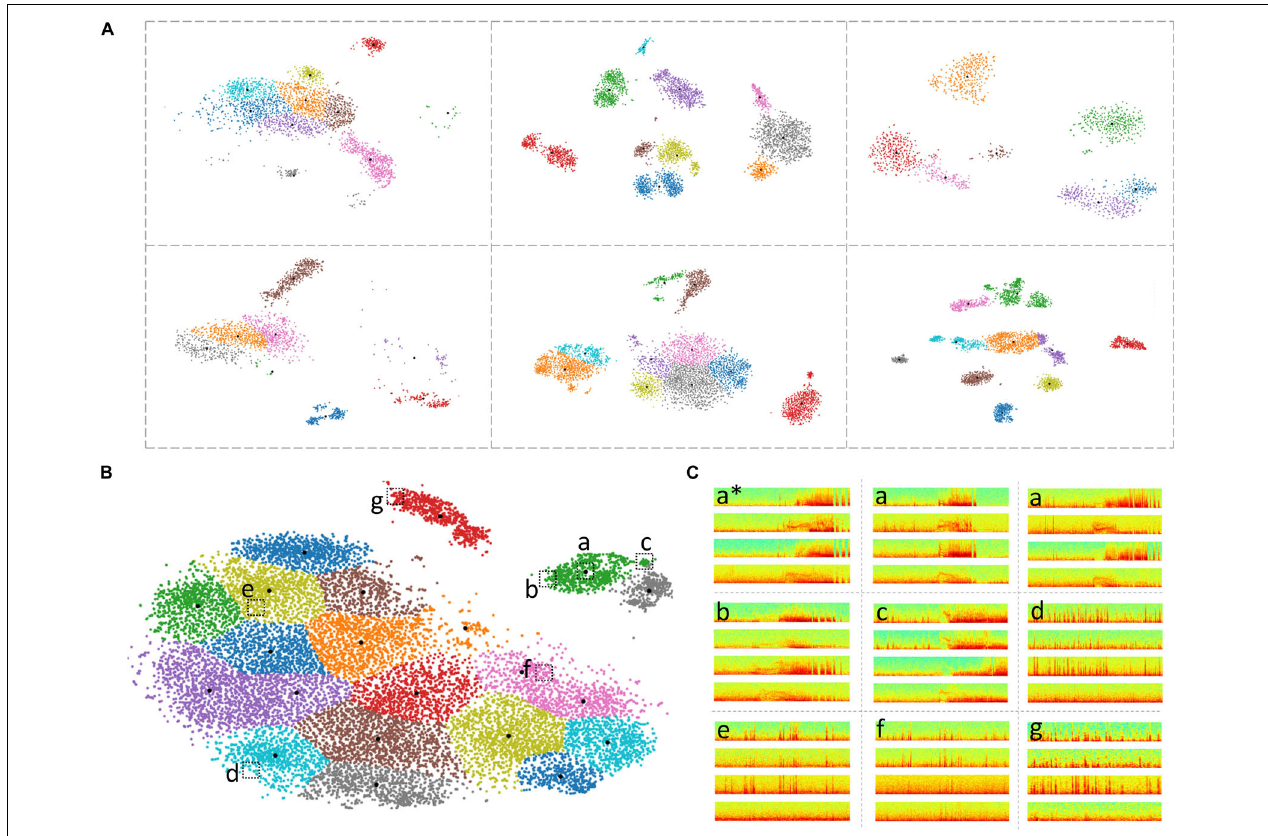
FIGURE 6 | Clustering of ECoG records in patient-specific 2D embedding spaces. (A) 2-dimensional embeddings of long episode (LE) electrocorticographic (ECoG) records from six example patients included in this study. Different numbers and patterns of clusters were observed in the patient-specific 2D embedding spaces. (B) 2D embeddings of 17,422 LE ECoG records from the patient with the most ECoG records included in this study. Only the green and gray clusters in the top right of the embedding space contained electrographic seizures. (C) Example ECoG records from different locations in the 2D embedding space shown in panel (B) . ECoG record denoted with ‘a*’ is the centroid ECoG record within the green cluster in panel (B) . ECoG records denoted with ‘a’ are two ECoG records that were closest to the centroid ECoG (a*). ECoGs records b and c are two example ECoG records further away from the centroid in the same green cluster. Three example ECoG records (d-f) from other areas of the embedding space contained interictal activity. ECoG record (g) is from a cluster (red cluster in panel B ) that exclusively contained short ( < 70 s) interictal ECoG